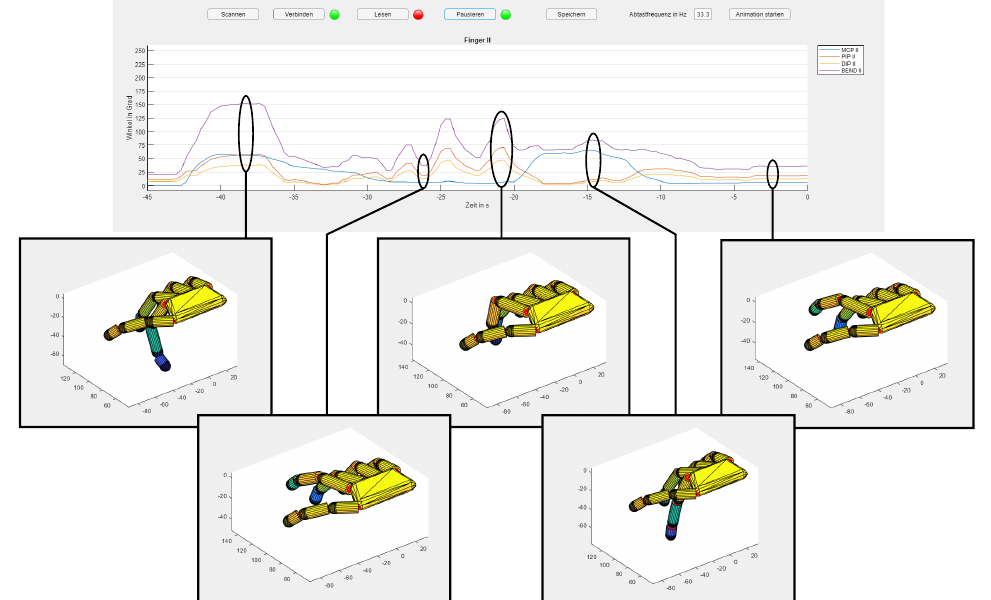
Figure 12. Series of screenshots of the 3D animation of a hand model using the MATLAB ® toolbox SynGrasp [51]. Finger II has been flexed and extended. Data stream shown in the subplot at the top with angle value (in degree) for the Distal Interphalangeal (DIP), Metacarpophalangeal (MCP), Proximal Interphalangeal (PIP) joint as well as overall bending of the finger (Bend